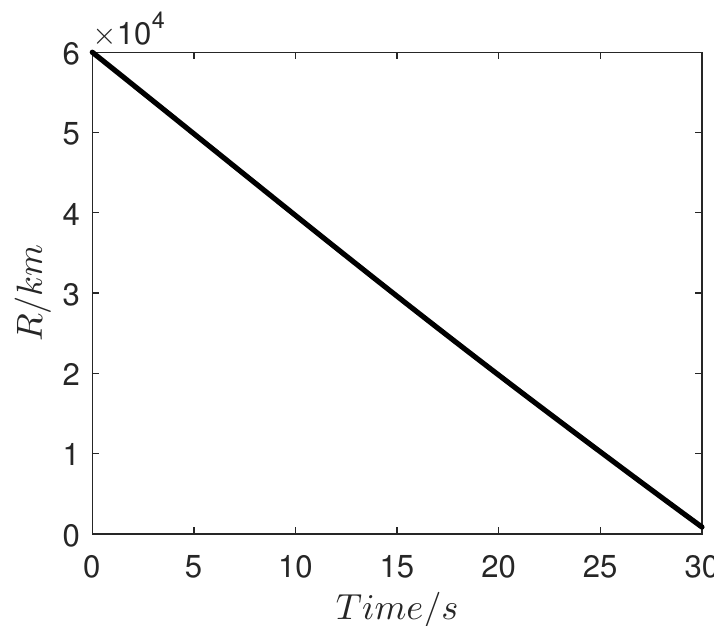
Figure 5. Curve of the relative distance R